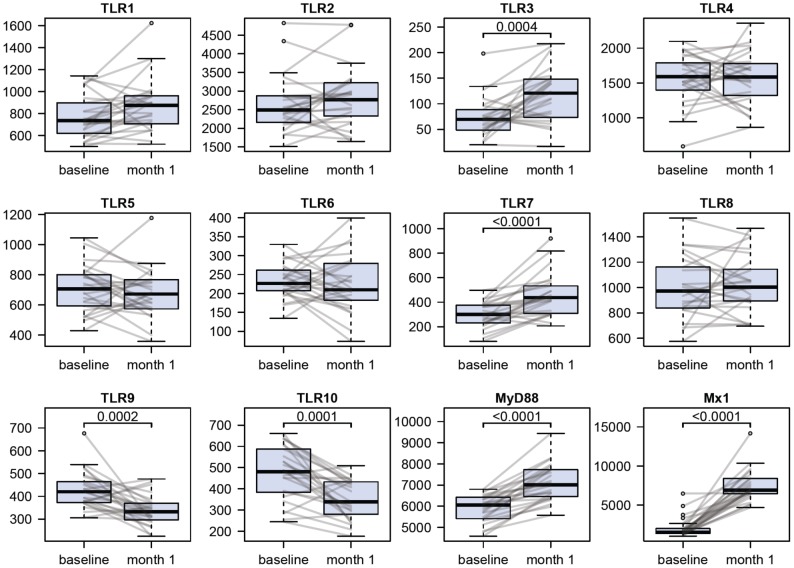
Regulation of TLR, MyD88, and MX1 mRNA expression in interferon-β-treated patients with MS.Expression levels of TLR1-10, MyD88, and MX1 mRNA were determined in PBMCs of 25 patients with RRMS by Affymetrix microarray analysis immediately before and one month after start of therapy with interferon-β-1b. Boxplots show medians, upper and lower quartiles as well as outliers, and graphically display the spread (interquartile range) of the pre-processed microarray data. Statistical significance of gene expression changes in response to therapy was assessed by Wilcoxon signed-rank test. p-values <0.01 are indicated.